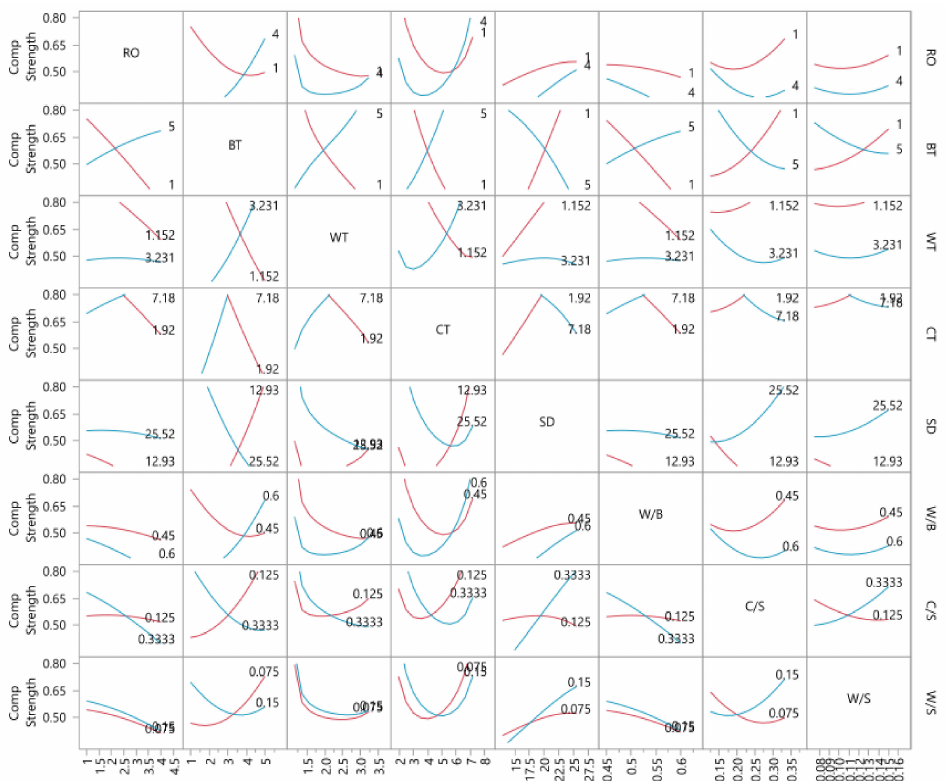
Figure 13. Interaction profile ranges for compressive strength with respect to